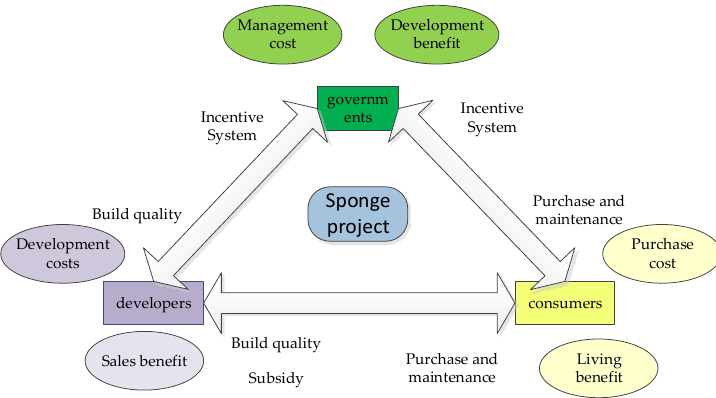
Figure 2. Interaction among government, developers, and consumers.